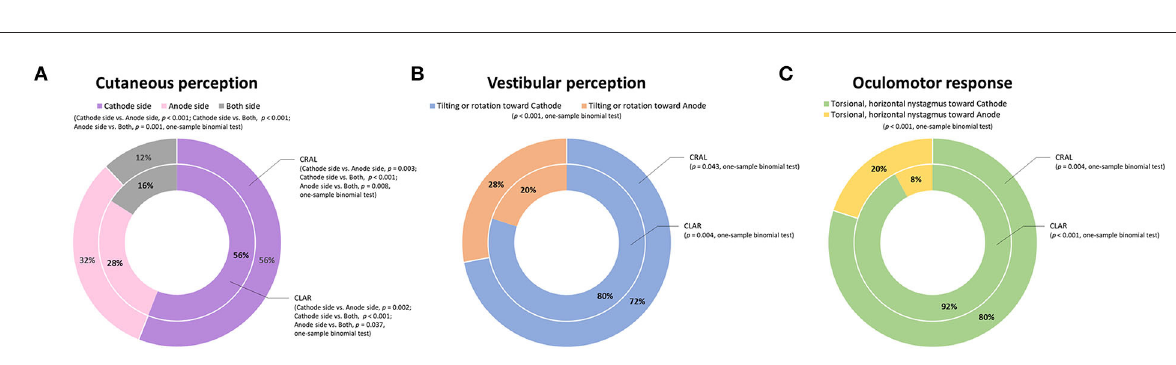
FIGURE3 Characteristics of galvanic vestibular stimulation (GVS)-induced cutaneous and vestibular perception and oculomotor responses depending on the stimulating paradigms; the cathode on the left and the anode on the right (CLAR, inside annulus) and the cathode on the right and the anode on the left (CRAL, outside annulus). Cutaneous perceptions were more frequent on the cathode side (56%) than the anode (30%) or both sides (14%; p = 0.001, chi-square one-variable test) (A) . Rotating and falling sensations were more frequently experienced toward the cathode (76%) than the anode (24%, p < 0.001, chi-square one-variable test) direction (B) . Nystagmoid ocular movements were observed more frequently with horizontal and torsional nystagmus toward the cathode (86%) than toward the anode (14%, p < 0.001, chi-square one-variable test) (C) . Values are presented as